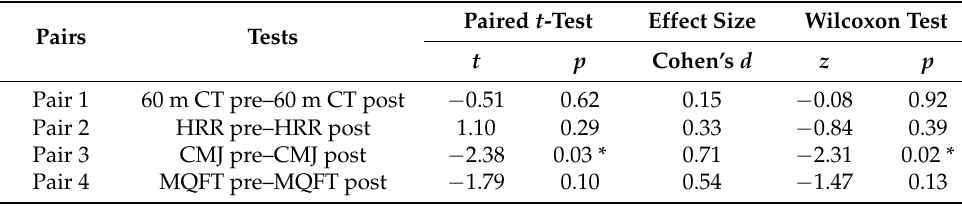
Table 2. Statistical analyses for all test